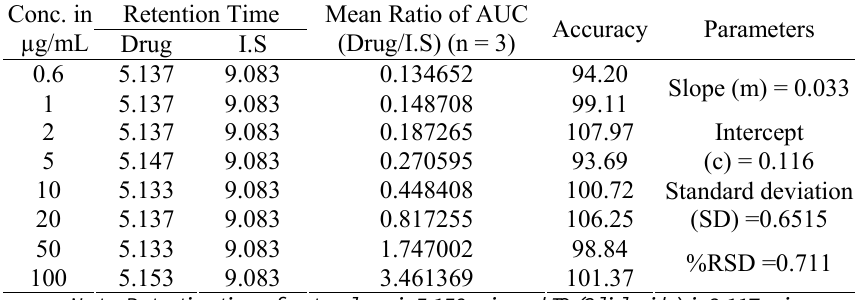
Figure 4. Linearity graph of metaxalone Table 3. Linearity of metaxalone